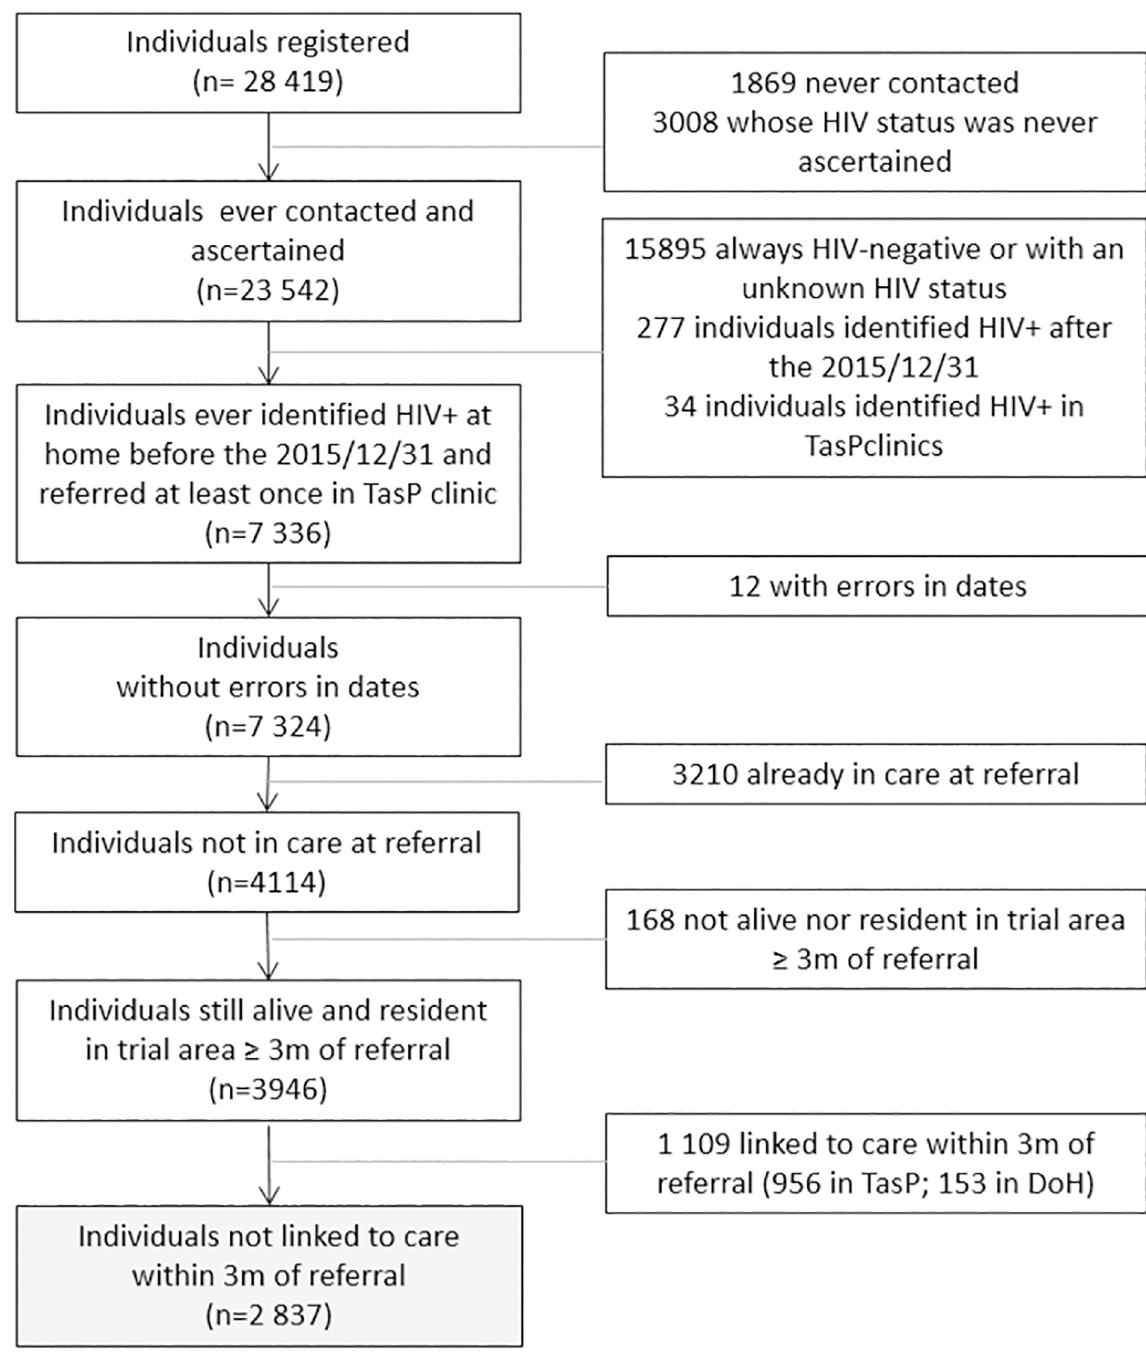
Fig 1. Flowchart of the population selection. ANRS 12249 TasP trial.